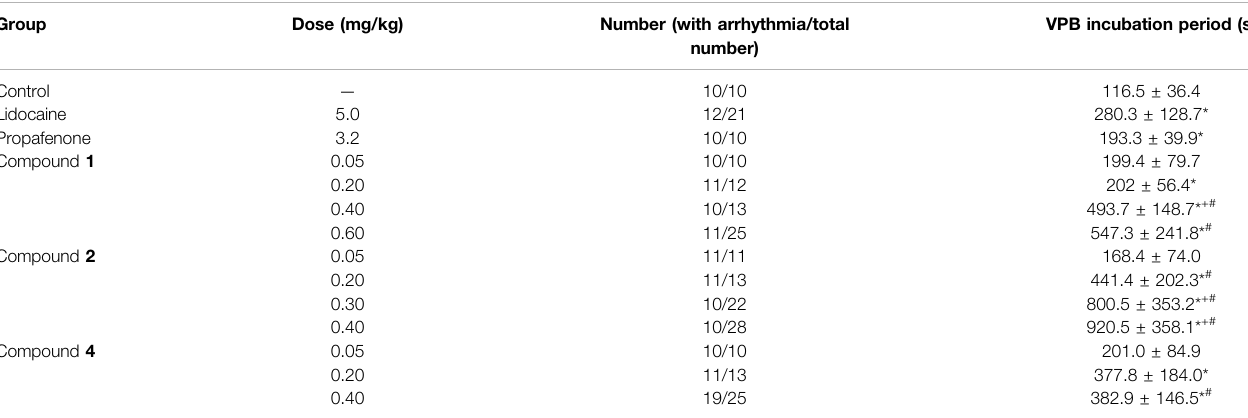
TABLE 5 | Effects of different compounds on VPB incubation period.